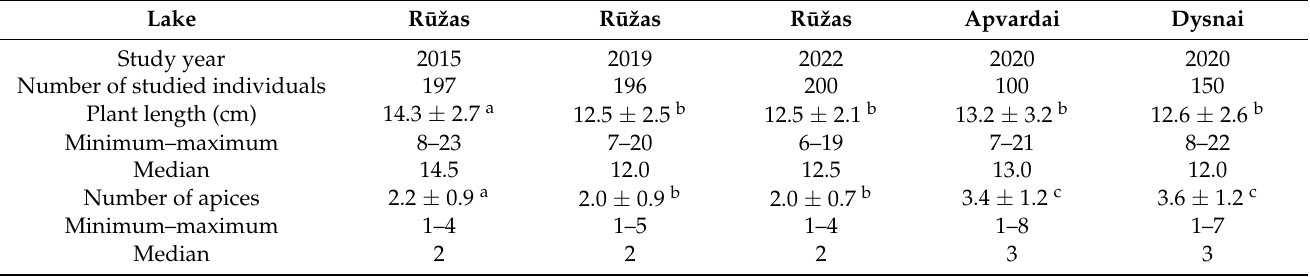
Table 3. Descriptive statistics of Aldrovanda vesiculosa individuals in different years and lakes (mean ± SD, minimum and maximum values, median). Different lower-case letters in superscript in- dicate significant differences ( p < 0.05) across rows according to Mann–Whitney pairwise